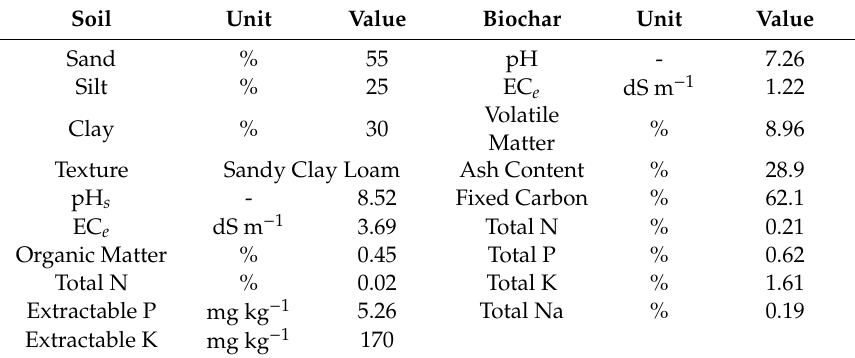
Table 1. Characteristics of soil and timber waste biochar